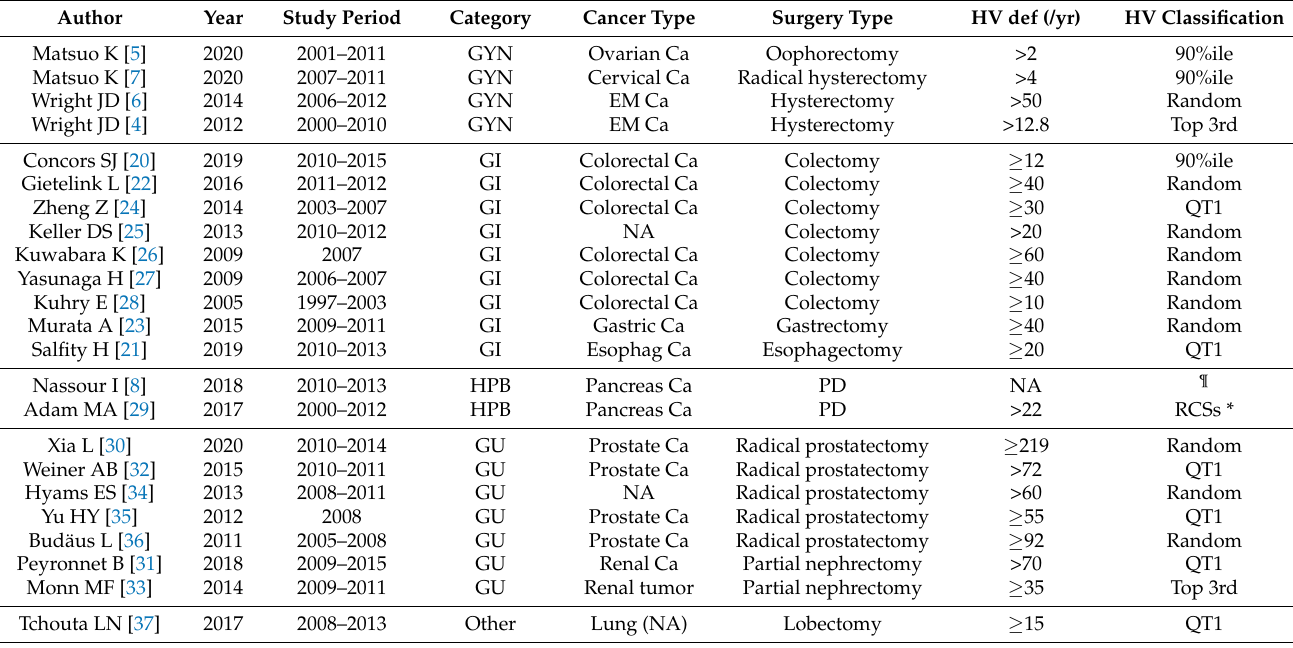
Table 1. Definition of high-volume